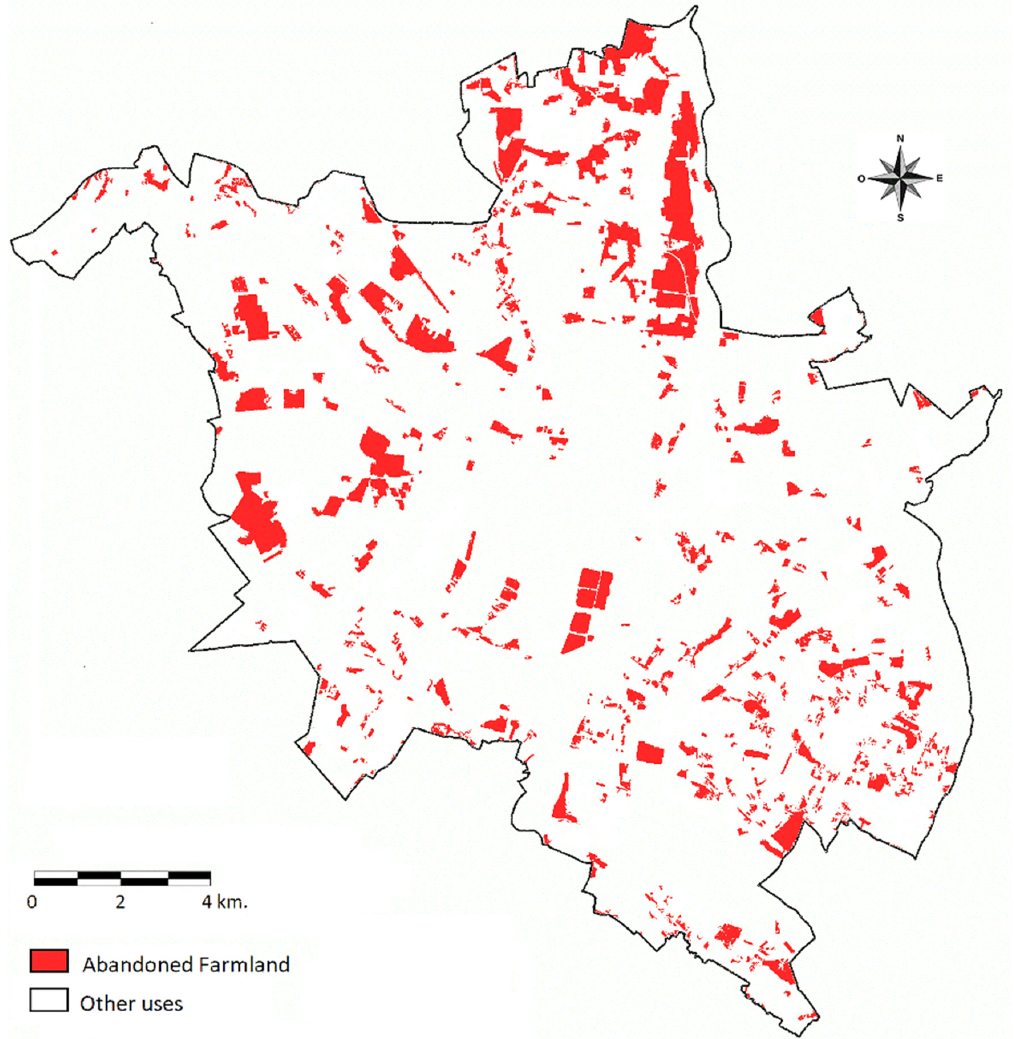
ISPRS Int. J. Geo-Inf. 2020 , 9 , 191 Figure 8. Map of abandoned land as derived from textural segmentation of the aerial image.